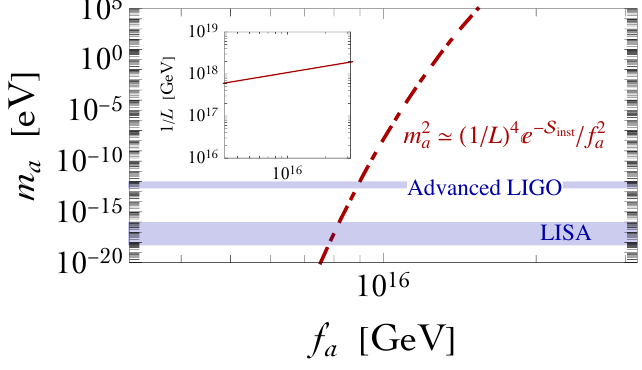
Figure 7 . Gravitational mass generated by non-perturbative Euclidean wormholes as a function of the Goldstone boson decay constant f a . In the inset plot, we show, in the same interval of f a , the inverse of the wormhole size L . The horizontal blue lines represent the mass range favored by the analysis in [64, 65] considering both Advanced LIGO ( m a = [2 (cid:2) 10 (cid:0) 13 ; 10 (cid:0) 12 ] eV) and LISA ( m a = [5 (cid:2) 10 (cid:0) 19 ; 5 (cid:2) 10 (cid:0) 16 ] eV) gravitational wave